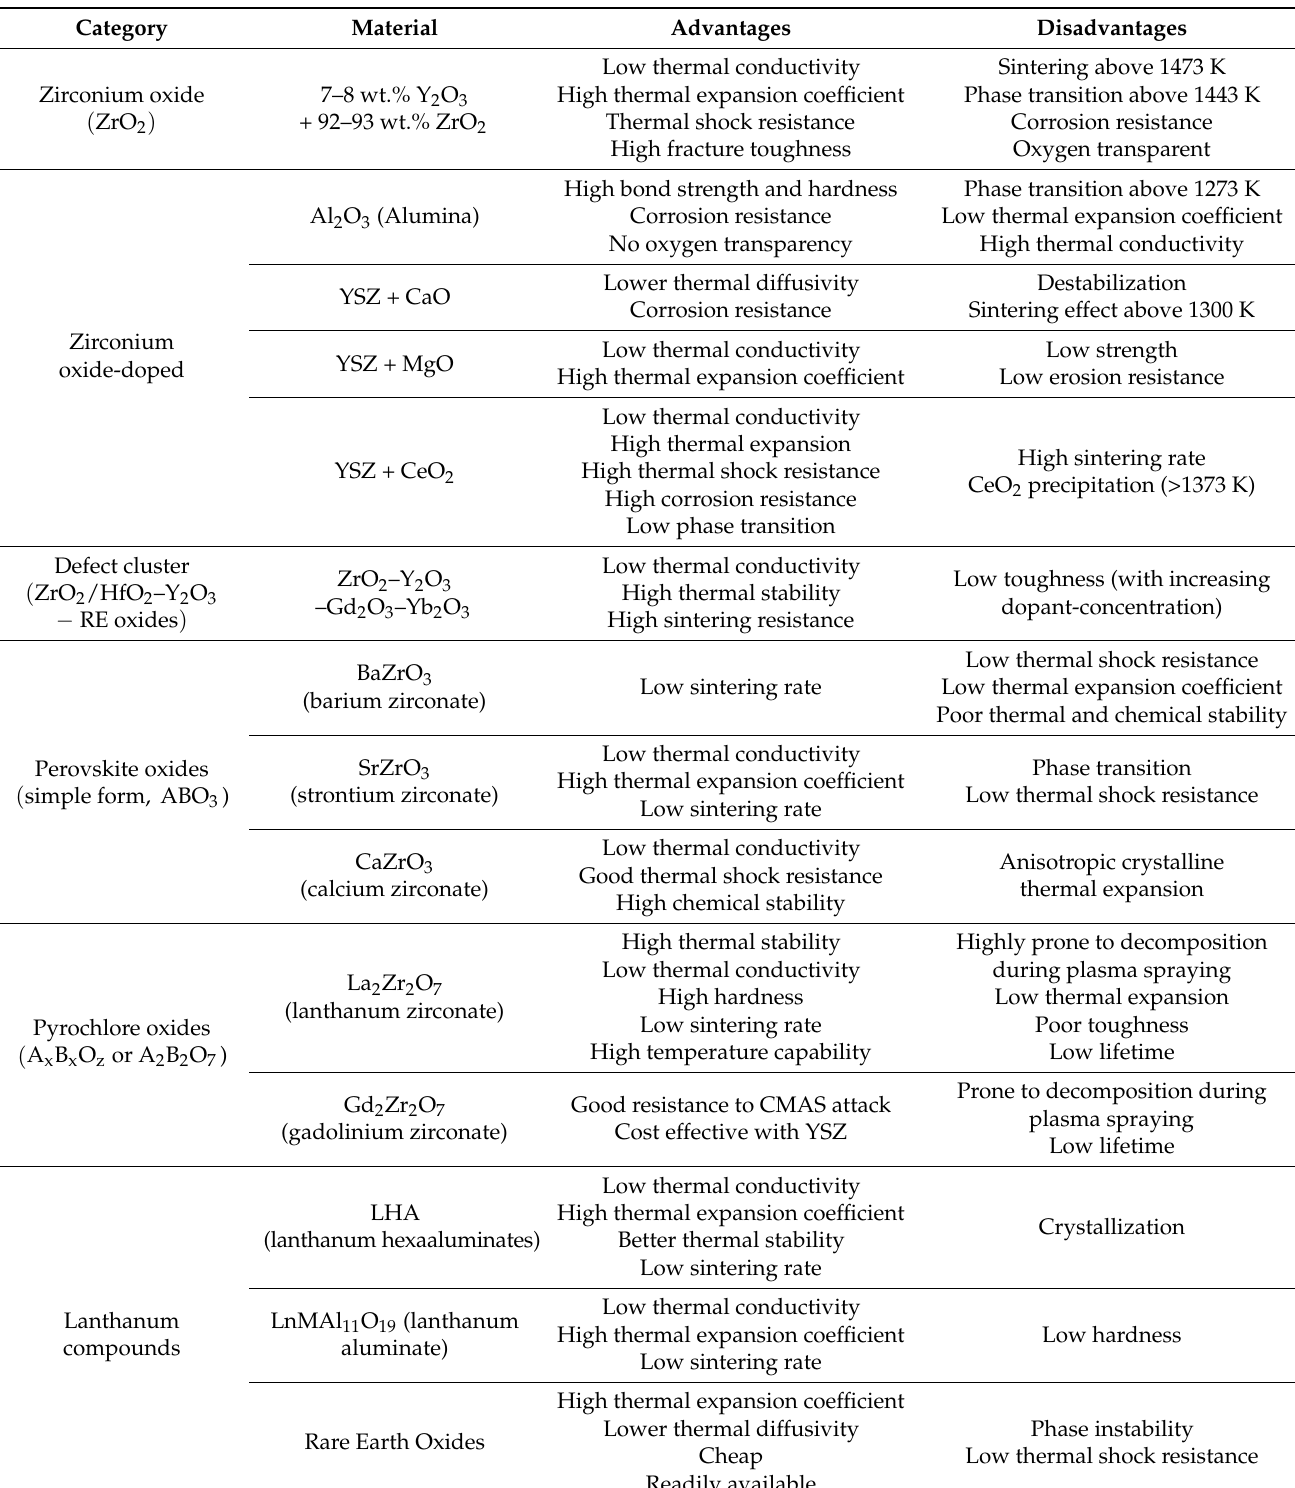
Table 2. Summary of parallel research on material alternatives to YSZ that could be used as TBCs based on ref.